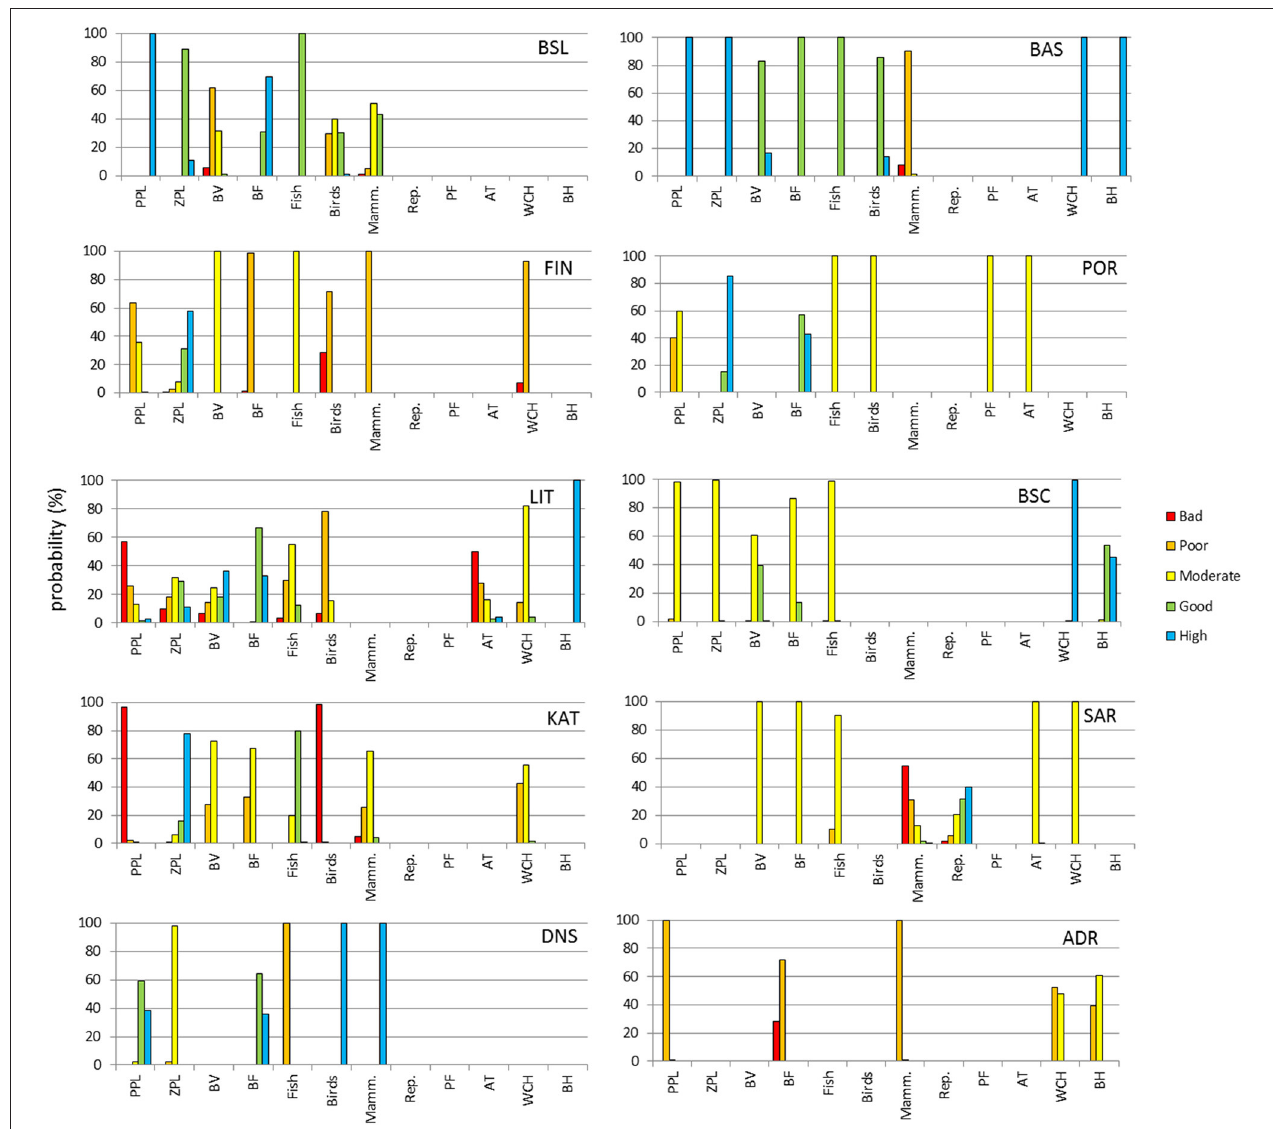
FIGURE 4 | Probabilities for the five environmental status classes separated by ecosystem component for each of the 10 case studies (for codes see Table 1). Ecosystem components considered are: Phytoplankton (PPL), zooplankton (ZPL), benthic vegetation (BV) benthic fauna (BF), fish, birds, mammals (Mamm.), reptiles (Rep.), pelagic fauna (PF), all taxa (AT), water column habitat (WCH), benthic habitat